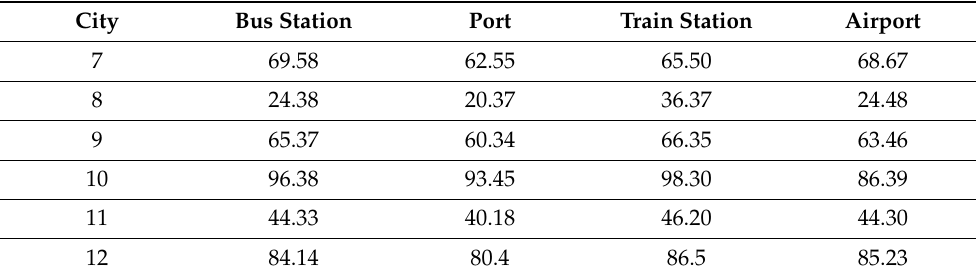
Table 4. Transit point coordinates of the simulated city